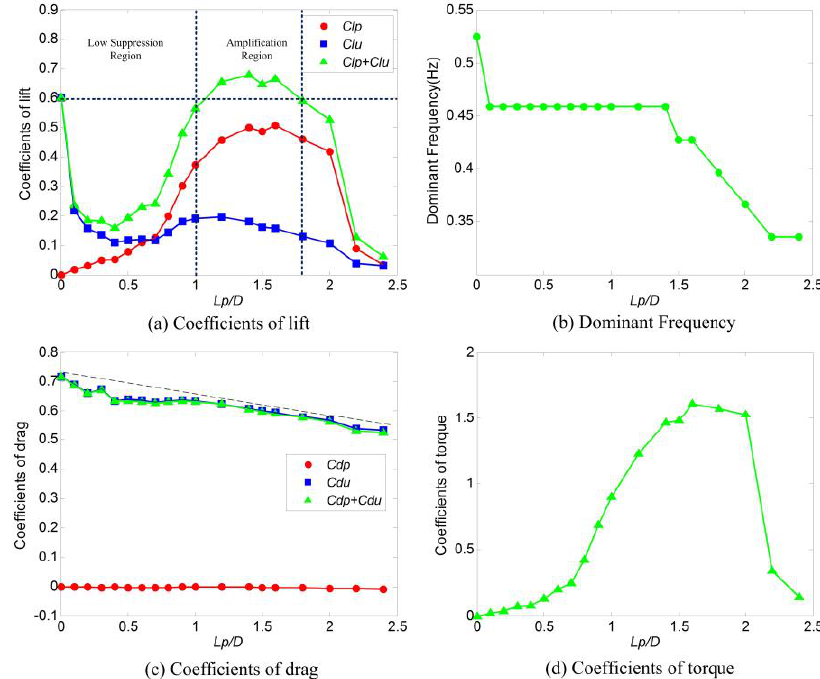
Figure 8. Results for the fixed plate simulations.